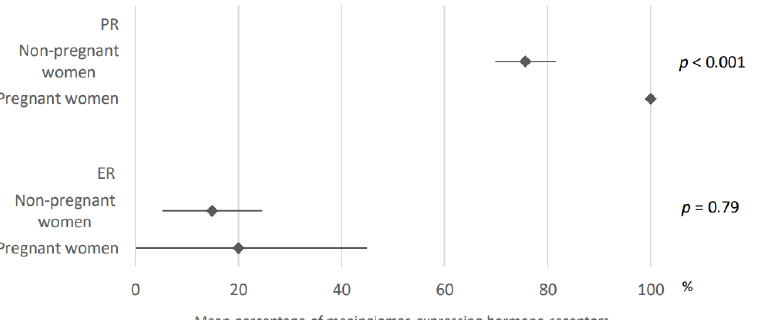
Figure 6. Comparison of hormone receptors expression within meningiomas developed in pregnant versus non-pregnant women. PR: progesterone receptors; ER: estrogen receptors. The results are expressed as a mean associated with their 95% confidence interval. Number of articles analyzed